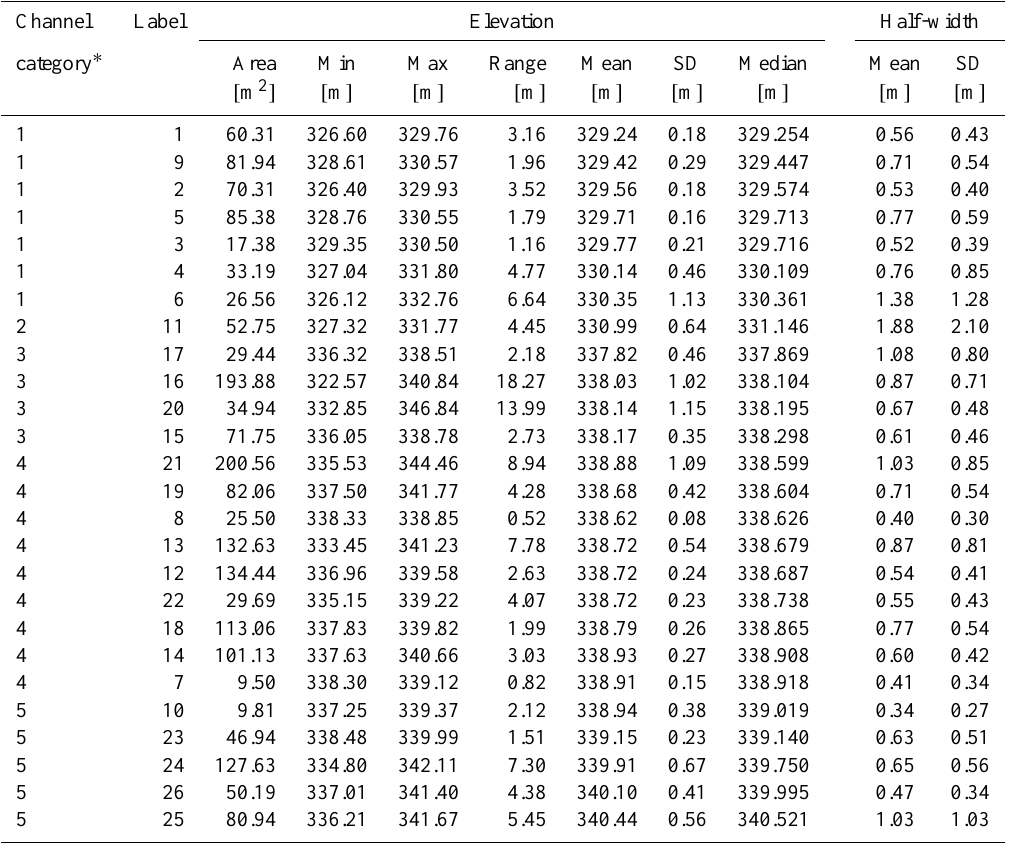
Figure 10. Ceiling channels resulting from the semi-automatic classification of the Domica ceiling, which were grouped according to their median elevation (a) reported in Table 6 and interpretation of their vertical displacement (b) . Table 6. Ceiling channels identified in the DEM_CH classification procedure and their summary statistics of elevation and channel half-